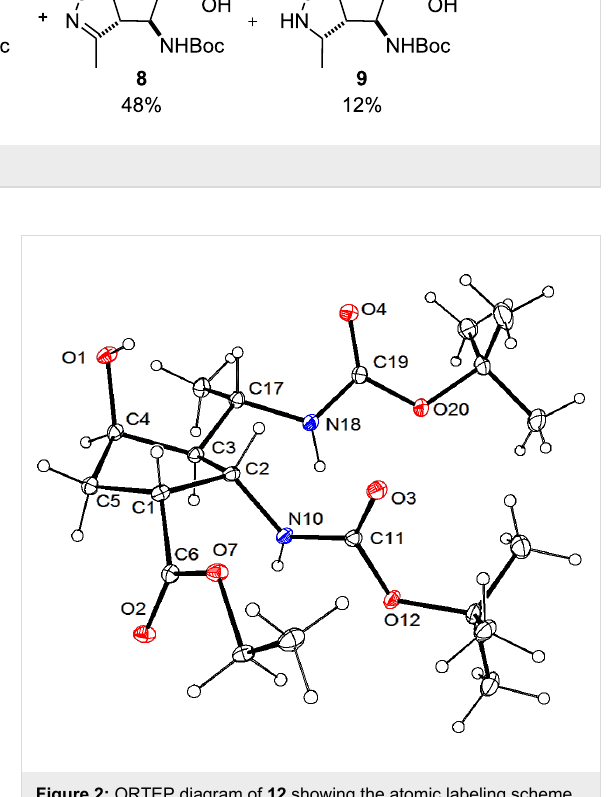
[49]. Reactions were carried out similarly with NaBH 4 in the presence of NiCl 2 in EtOH/H 2 O and led selectively to the yields (Scheme 5) as single